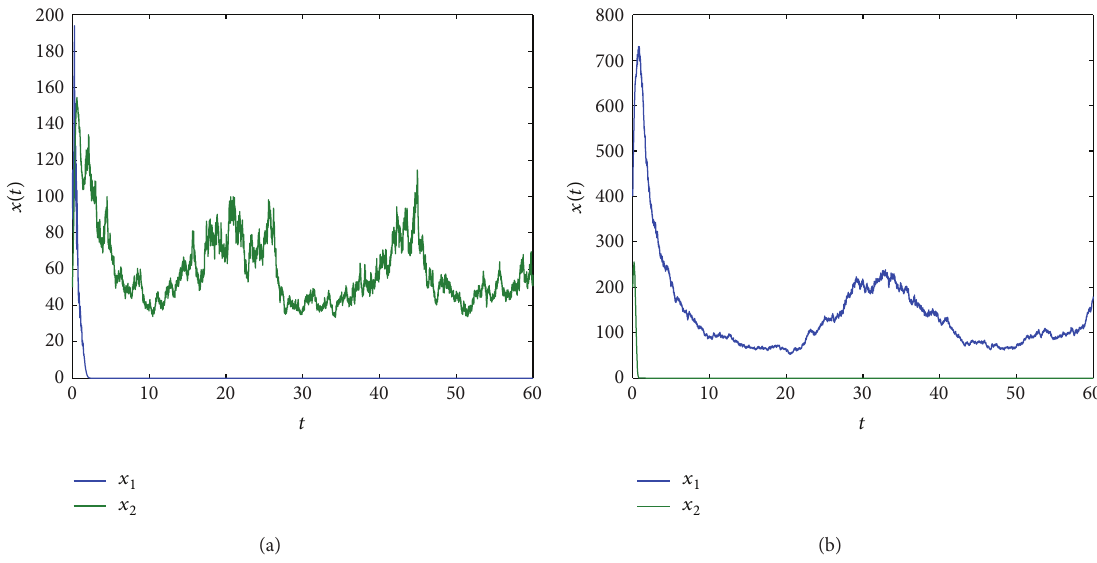
Figure 2: Solutions of systems (89) for 𝑟 1 (𝑡) = 𝑟 2 (𝑡) = 1 + (3/(1 + 𝑡 2 )) , 𝜎 11 (𝑡) = 1.45 − (1/√1 + 𝑡) , 𝜎 22 (𝑡) = 0.1(1 − (1/√1 + 𝑡)) , 𝜃 11 (𝑡) = 0 , and 𝜃 22 (𝑡) = 1/2 ; initial data 𝑥 1 (0) = 100 , 𝑥 2 (0) = 50 (a), 𝑟 1 (𝑡) = 1.5 + sin 𝑡 + (1/(1 + 𝑡 2 )) , 𝑟 2 (𝑡) = 1.5 + (2/(1 + 𝑡 2 )) , 𝜎 11 (𝑡) = 1.8 − (1/√1 + 𝑡) , (𝑡) = 1.8 − (1/(1 + 𝑡)) , 𝜃 (𝑡) = 1 , and 𝜃 (𝑡) = 0 initial data 𝑥 (0) = 400 , 𝑥 (0) = 200 (b). 𝜎 22 11 22 1 2